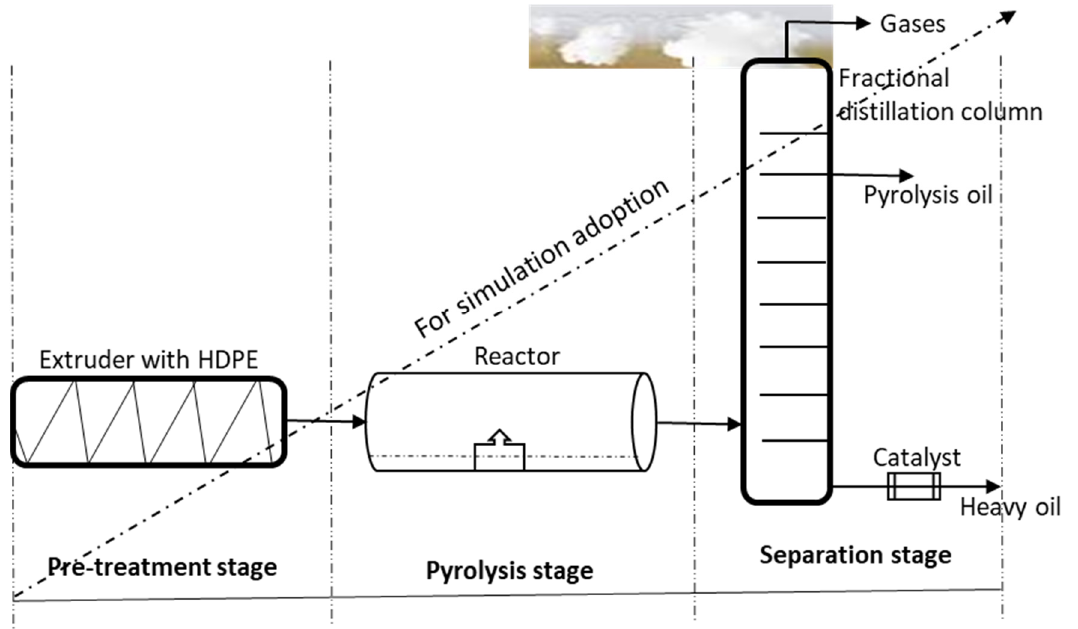
Figure 1. Experimental schematic of a small-scale pyrolysis plant to convert HDPE to